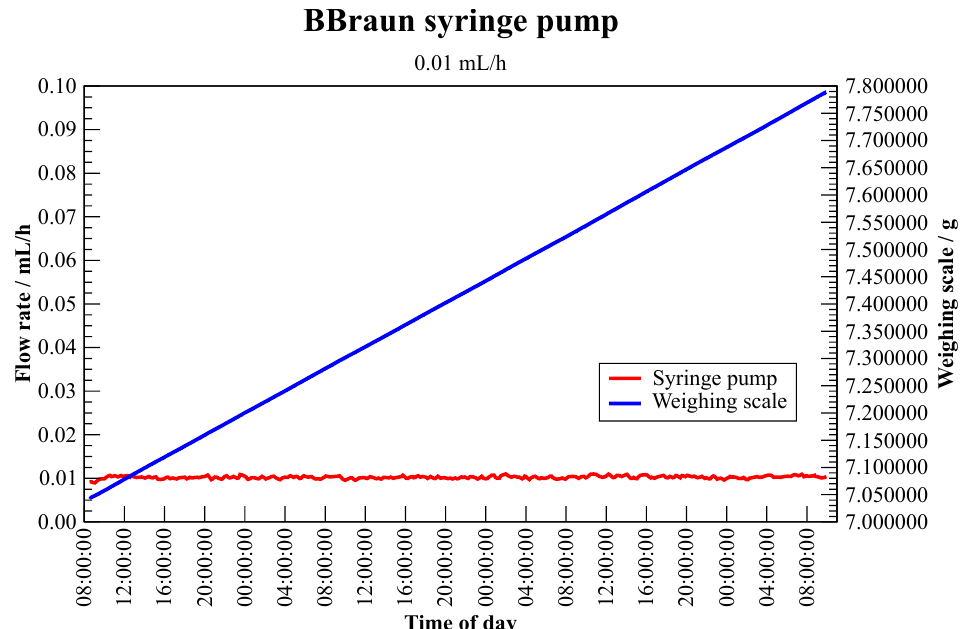
Figure 7. Measurement results of the BBraun syringe pump for measurements over three day (72h) for a preset flow rate of 0.01mLh − 1 using a 10mL disposable